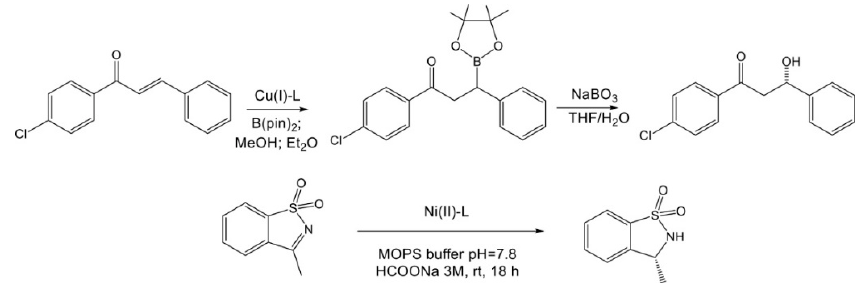
Figure 10. Catalytic reactions for Cu 2+ — and Ni 2+ —biomass hybrid catalysts.